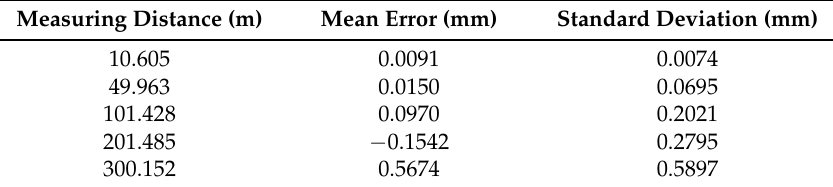
Table 1. Measurement errors of the video deflectometer at different measuring